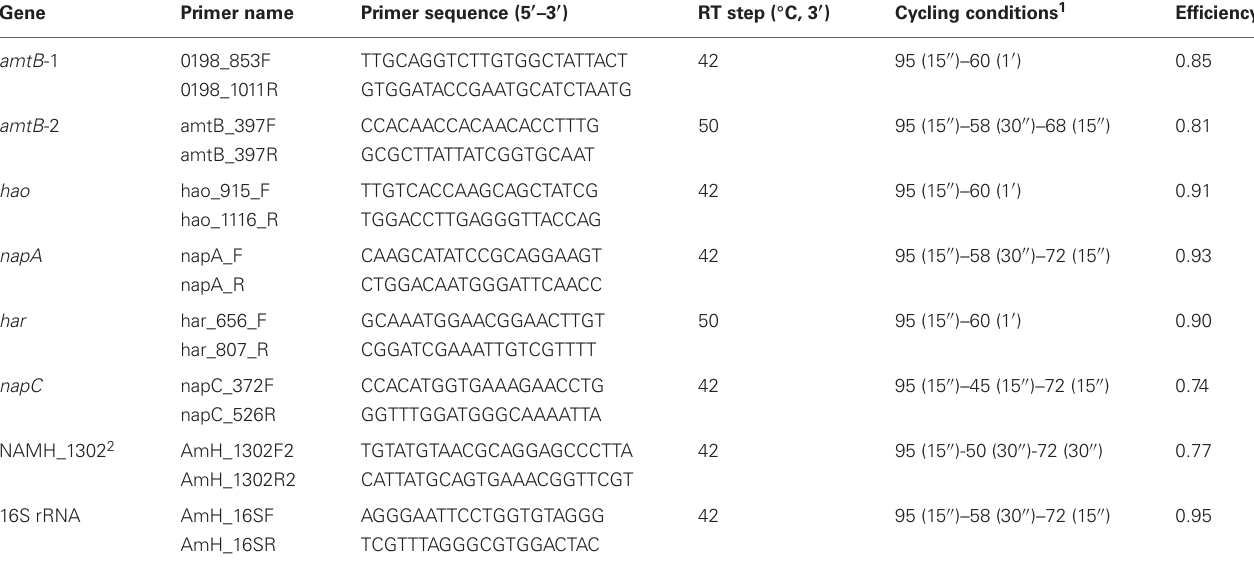
Table 3 | Primers and conditions for Q-RT-PCR quantification of specific genes in total RNA samples extracted from N. profundicola . Gene Primer